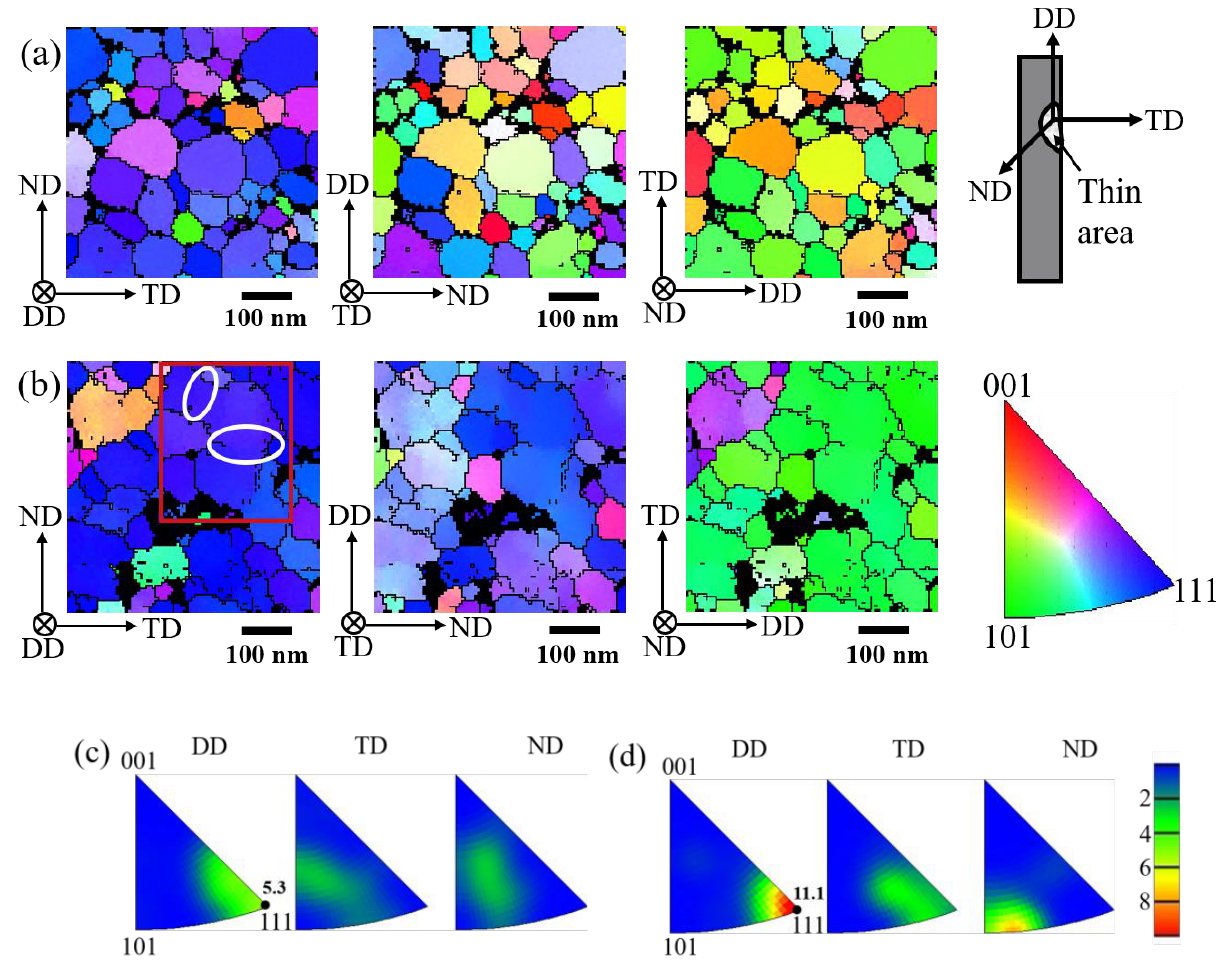
Figure 7. ( a , b ) The inverse pole figure (IPF) maps of the as-received and trained sample, respectively; ( c , d ) IPFs of the as-received and trained sample, respectively.